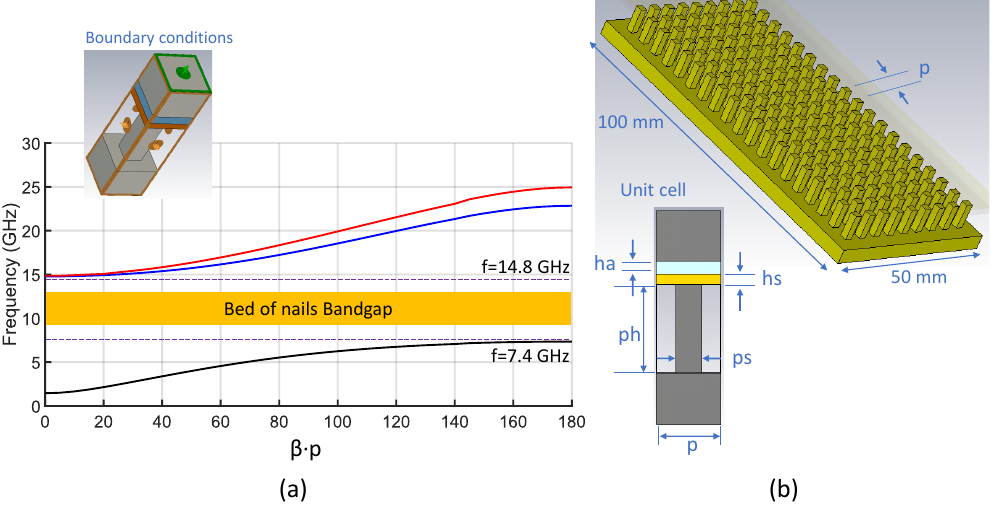
Figure 3. ( a ) Dispersion diagram of the bed of nails. ( b ) Finite (100 mm × 50 mm) periodic array of pins and unit cell parameters (ph = 7 mm, ps = 2 mm, p = 5 mm, ha = 1 mm, hs = 0.79 mm)